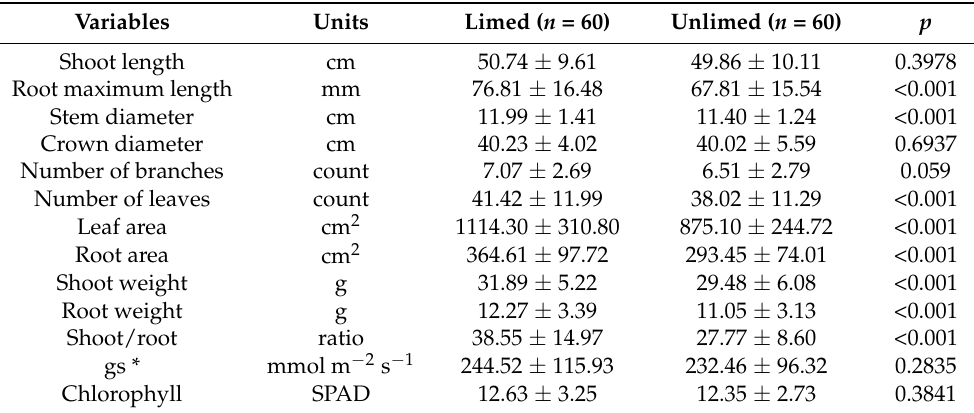
Table 3. Effect of soil acidity on biometric characteristics (height, diameter, number of leaves, leaf, and root area, as well as shoot and root biomass) and physiologic characteristics (stomatal conductivity—gs and chlorophyll